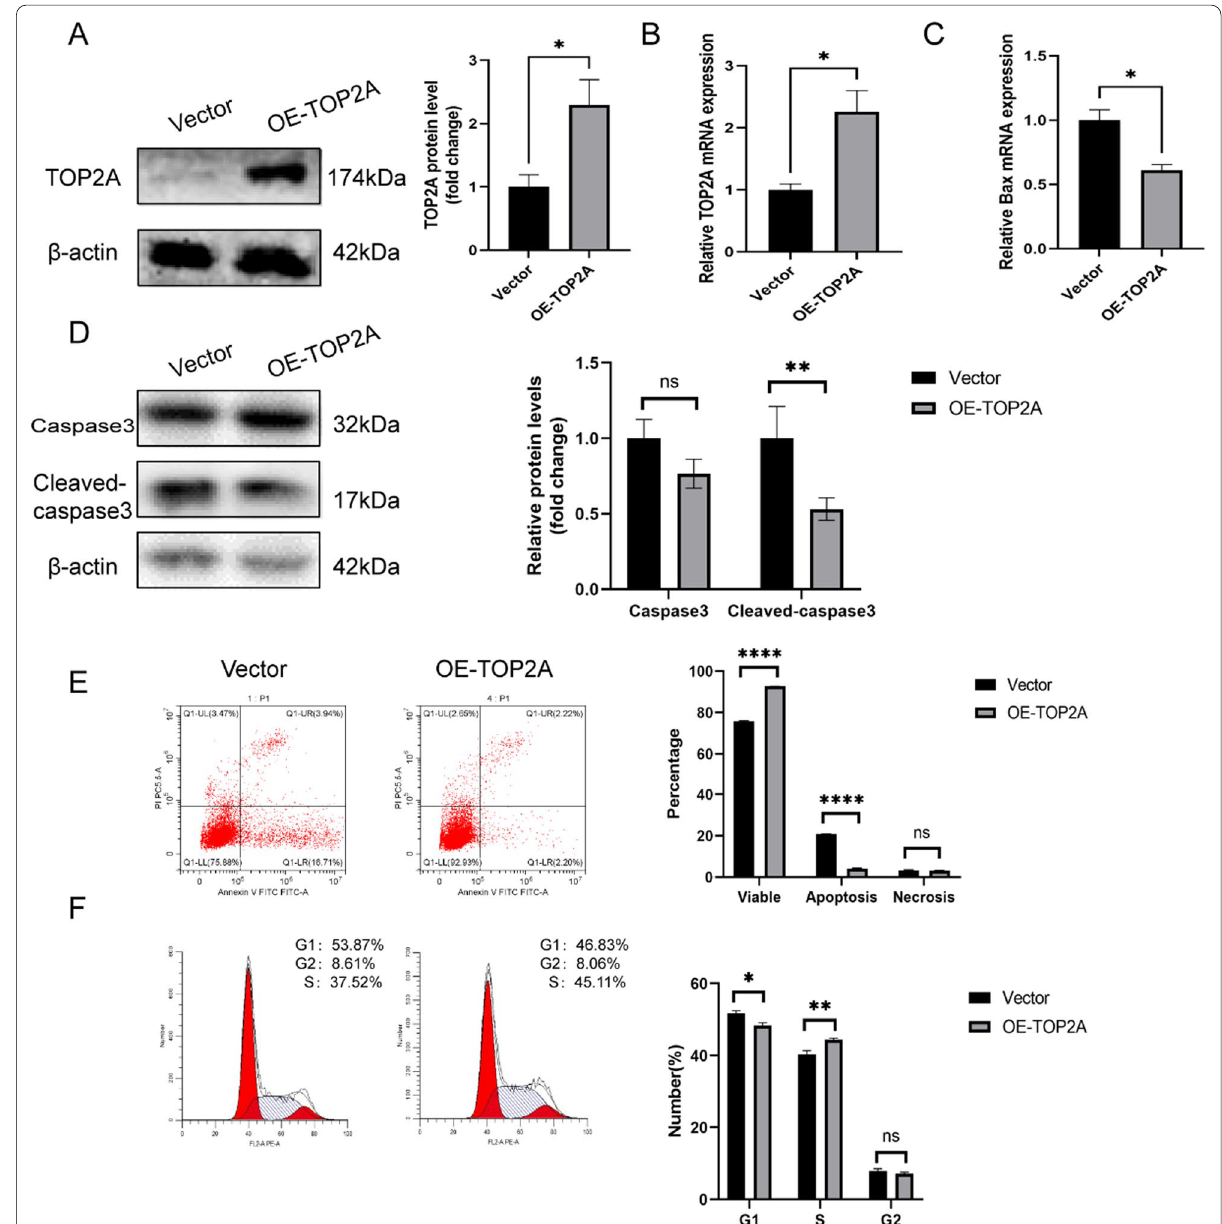
Fig. 3 TOP2A overexpression promotes proliferation cell cycle, and inhibits apoptosis in trophoblasts. A Western Blot was used to test the efficiency of plasmid transfection. B mRNA levels of TOP2A were assessed in HTR-8/SVneo cells after plasmid transfection. C q-PCR was used to assess the mRNA level of Bax , an apoptosis-related gene, after TOP2A overexpression. D The effect of TOP2A overexpression on the protein levels of cleaved-caspase3 and caspase3 were analysed using western blot. E Apoptosis was assessed using flow cytometry analysis. F Flow cytometry analysis was used to compare differences in cell cycle in the two groups Each in vitro experiment was repeated three times, and data are presented as the mean SEM. * P < 0.05, ** P < 0.01, **** P < 0.0001. ns no statistical ±